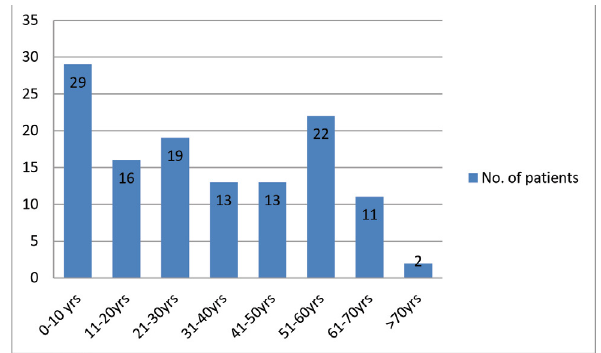
Figure 1: Distribution of the age of the patients (n=125)